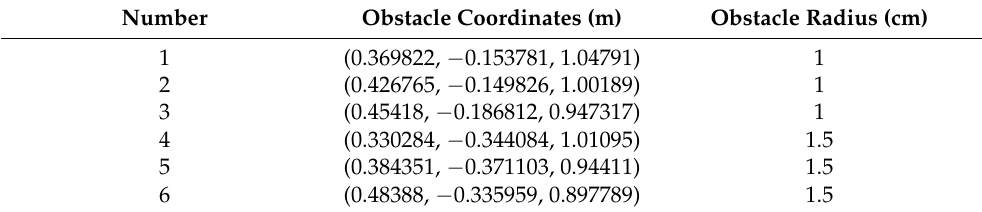
Table 7. Obstacle information.